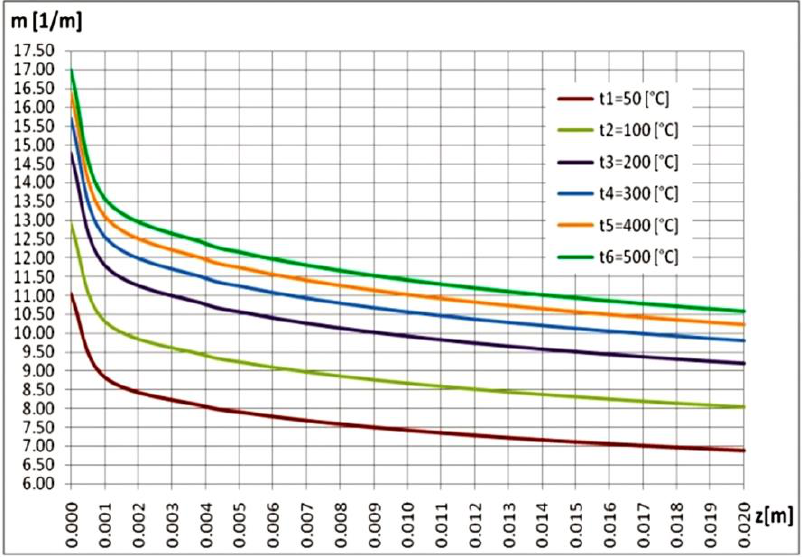
Figure 18. The variation in the parameter “ m ” along the first significant interval of the bar ( (cid:96) I = z = [ 0.000 − 0.020 ] m ) , for α g = 0 ◦